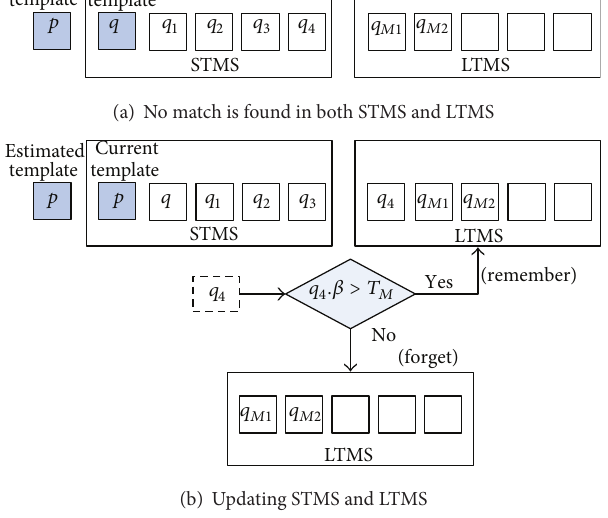
Figure 8: Illustration of updating STMS and LTMS when no match is found in both memory